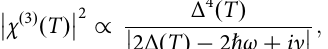
Fig. 2 Transient optical conductivity of photoexcited FeSe 0.5 Te 0.5 below T c . a Schematic illustration of the optical pump – terahertz (THz) probe experiment. A near-infrared pump pulse is shown by red. b , c Time evolution of the pump-induced conductivity change, Δ ~ σ ω ; t pp real part; and c : imaginary part), where ω is the angular frequency of the THz probe pulse and t pp is the pump – probe delay time. Vertical dashed lines show the probe photon energies of b _ ω probe = 9.5 meV and c 1.0 meV, at which Δ ~ σ ω probe ; t pp denote (i) t pp = 1.4 ps and (ii) 10 ps, which correspond to d – f , respectively. Time origin ( t pp = 0 ps), indicated by a black horizontal dotted line, is de fi ned by the pump arrival time to the sample. The pump fl uence was 2.6 µ J cm − 2 . d Transient optical conductivities, ~ σ ω ; t pp imaginary part) and e the corresponding imaginary part of the differential optical conductivity, Δ σ 2 ð ω Þ . f ~ σ ω ; t pp imaginary part). ~ σ eq ω ð Þ at 14 K are also shown by dashed